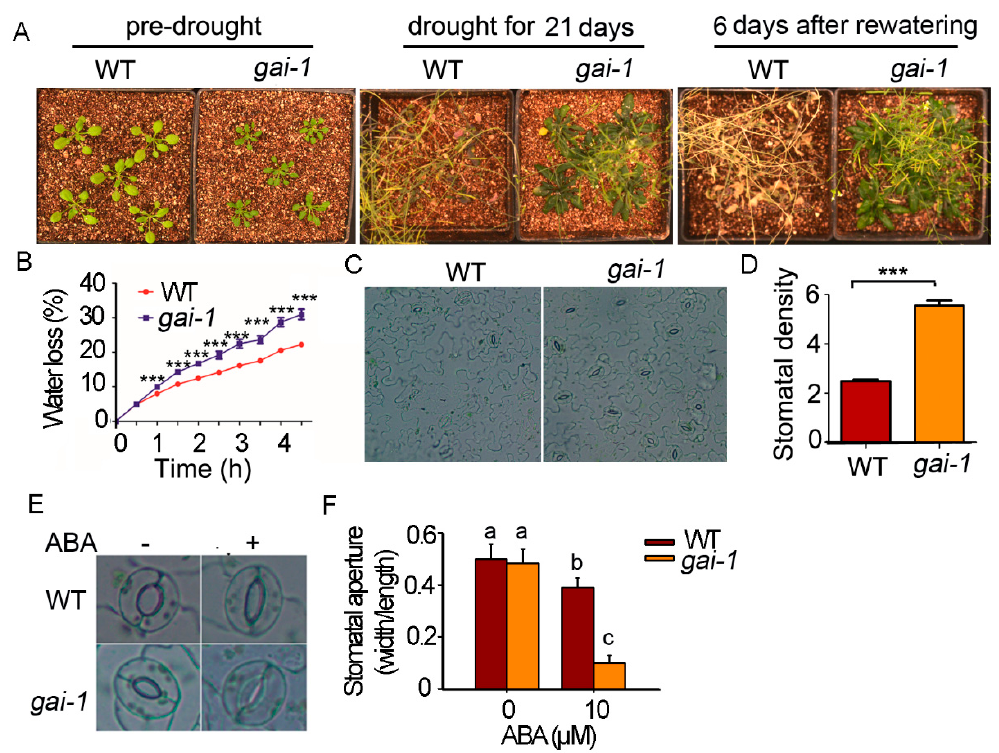
Figure 1. The gai-1 (gibberellin insensitive 1) mutant is more tolerant to drought stress than WT (wild type). ( A ) gai-1 mutant plants showed tolerance to dehydration stress. gai-1 mutant plants showed the ability to withstand long drought conditions without negative effects whereas the wild type under the same conditions completely wilted. ( B ) gai-1 plants showed increased water loss compared to WT. Data shown are the means ± SDs from three biological repeats ( n = 3, eight leaves from eight plants were used for each repeat, p < 0.001). ( C , D ) Stomatal density of WT and gai-1 mutant. Stomatal density was observed from comparable age leaves of 3 week old wild type and gai-1 plants. The stomatal density was represent by number of stomata per millimeters squared. Data shown are the means ± SDs from three biological repeats ( n = 3, five leaves from five plants were used for each repeat, p < 0.001). ( E ) Representative stomata of the WT and gai-1 mutant under control and abscisic acid (ABA) treatment conditions. Leaves of the WT and gai-1 mutant were treated with 10 µM ABA for 2 h (+), and ( − ) represents leaves without ABA treatment. ( F ) Stomatal apertures of the WT and gai-1 mutant corresponding to ( E ). Values are mean ratios of width to length ± SDs of three independent experiments. Letters indicate significant differences from the WT (0 ABA treatment) according to the Student’s Newman–Kuels test (*** p < 0.05).